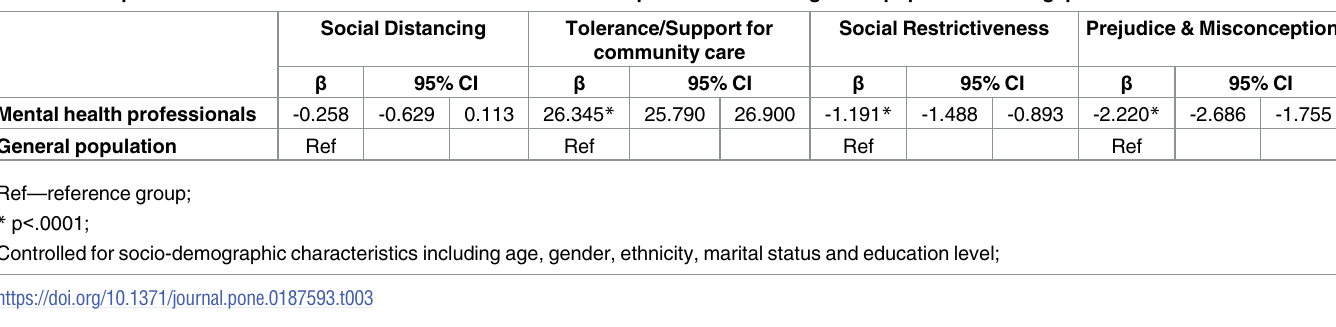
Table 3. Comparison of AMI-SG factor scores between mental health professionals and general population in